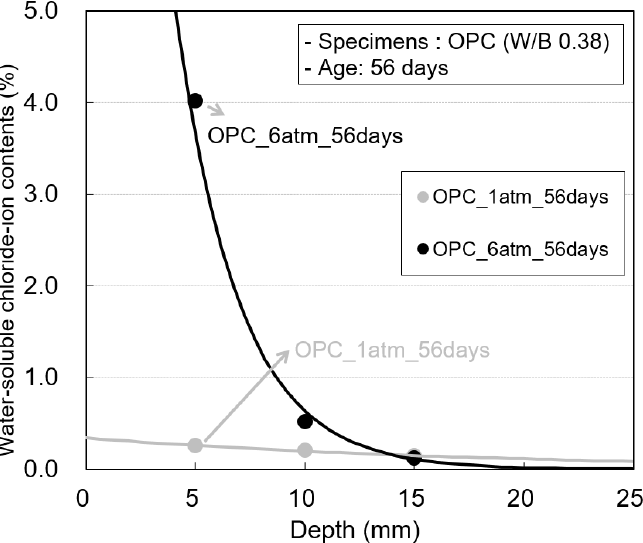
Figure 9. Chloride-ion penetration depth according to the pressure change of the OPC specimen.